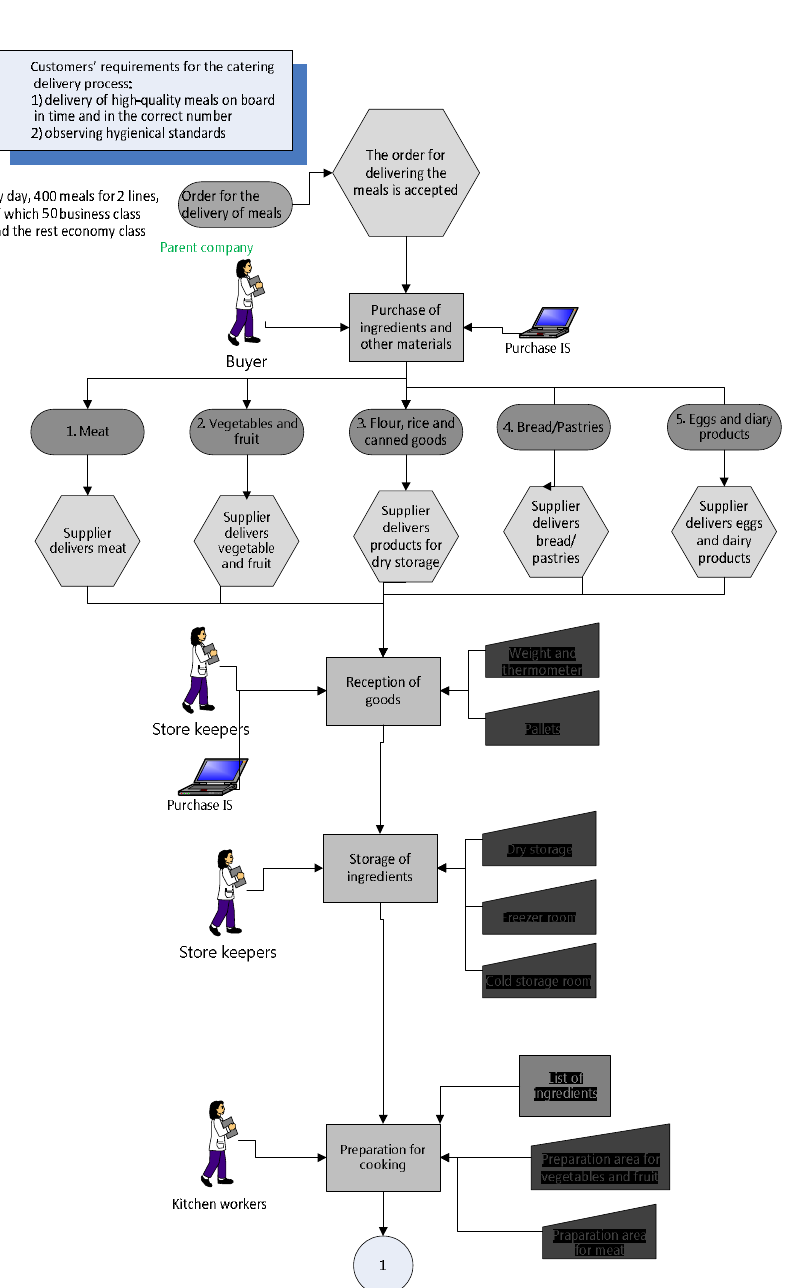
Figure – 1 Process model for catering deliveries to airplanes (part